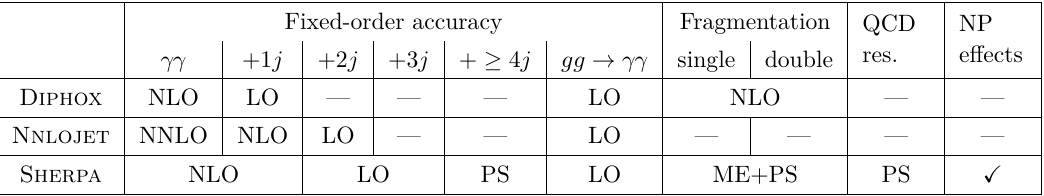
Fixed-order NNLO with N NLOJET